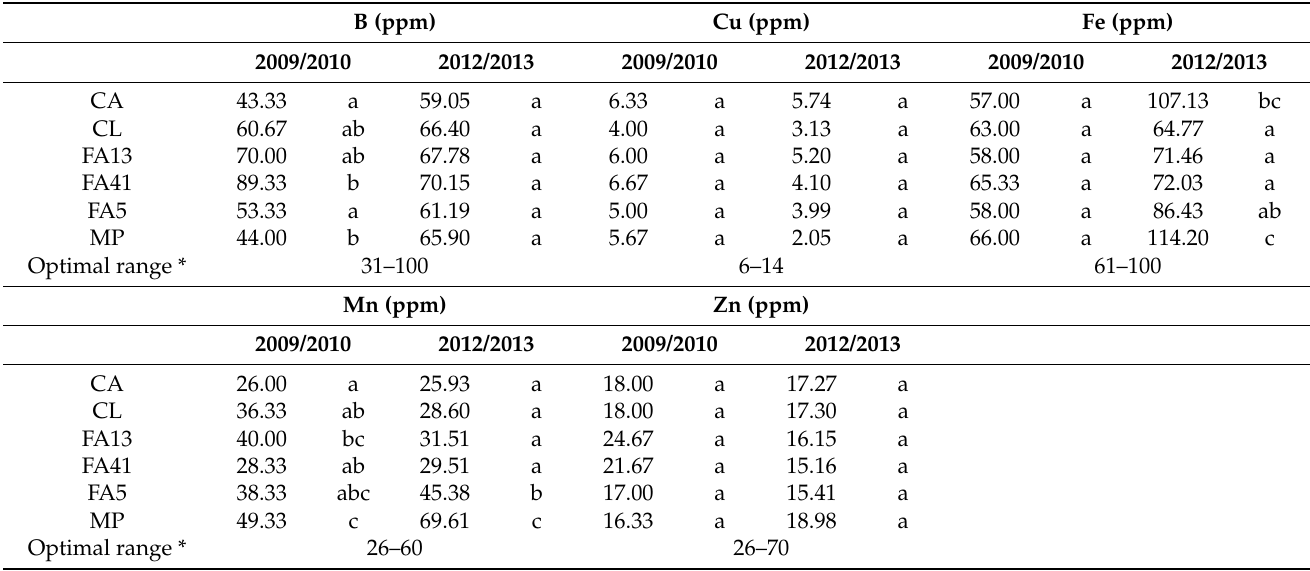
Table 3. Effect of rootstocks on ‘Lane Late’ navel orange leaf micro-nutrients (B, Cu, Fe, Mn, and Zn) contents over two growing seasons, 2009/2010 and